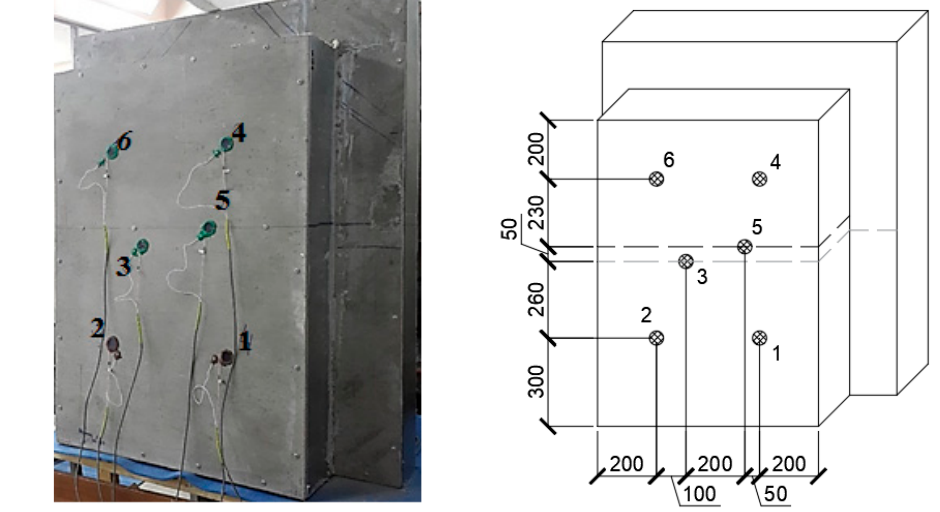
Figure 4. Test setup for specimen No. 1.